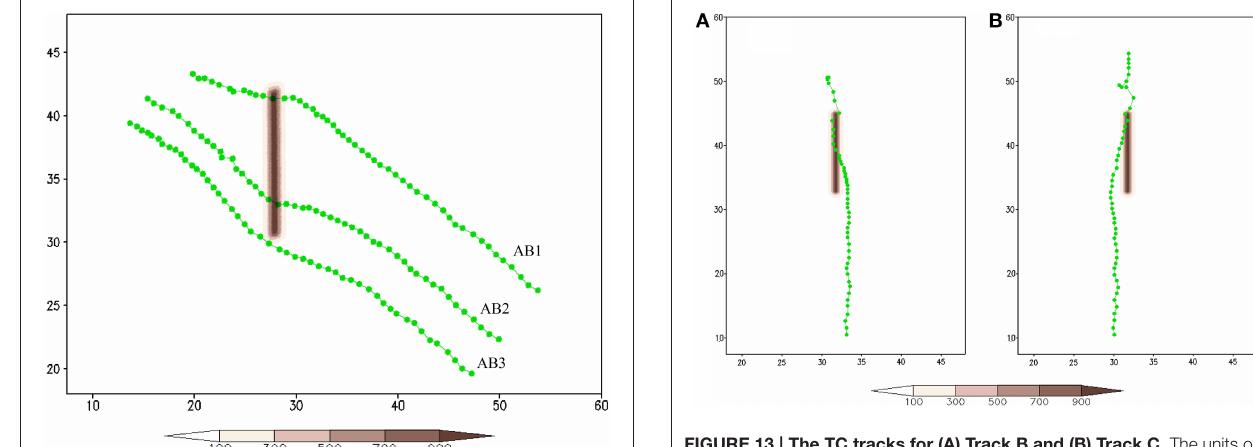
blocking caused by approach angle. It is interesting to observe that track AB1 is curved opposite to tracks AB2 and AB3 (i.e.,